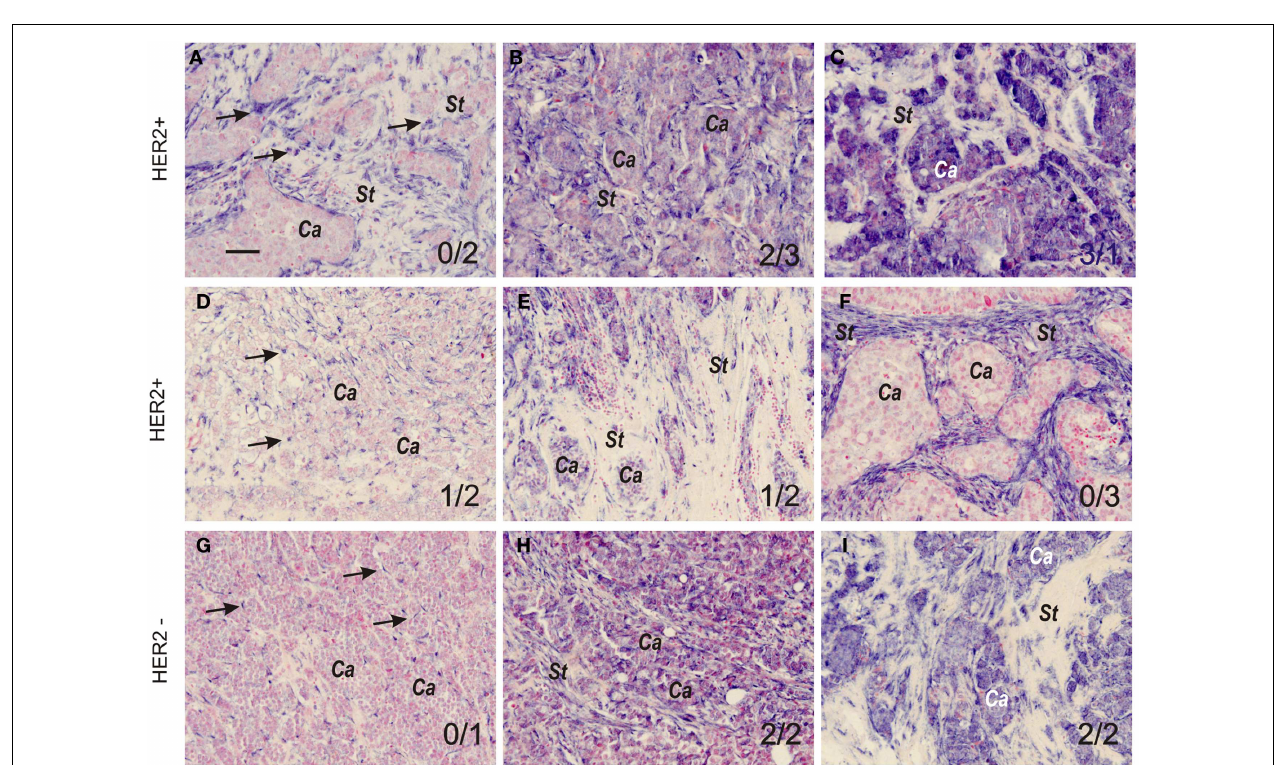
miR-21 positive stromal cells.The variations in miR-21 ISH signal intensity and prevalence of positive cells were scored 0, 1, 2, or 3 by two observers (see Material and Methods section) in both cancer and stromal cells.The miR-21 CC and miR-21 St scores are indicated (miR-21 CC /miR-21 St ). All sections were counter stained with nuclear fast red.The examples are from tumors in the reference group and are representative for the individual tumors. Bar: 50 µ